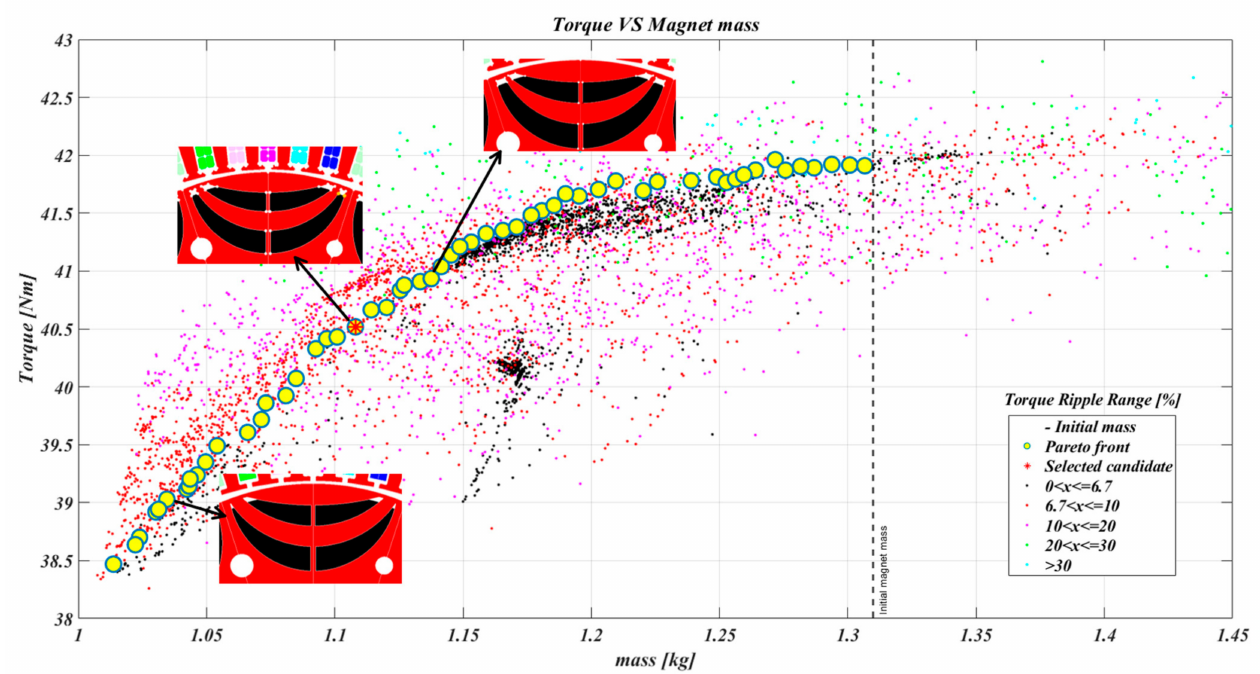
Figure 16. Rotor optimization process results and Pareto front.